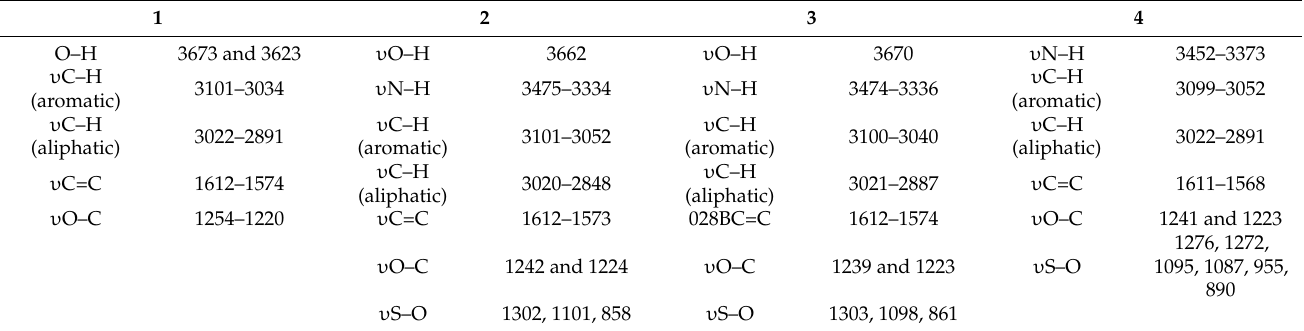
Table 5. Some important wavenumbers (cm − 1 ) scaled by a factor of 0.9608 for the investigated